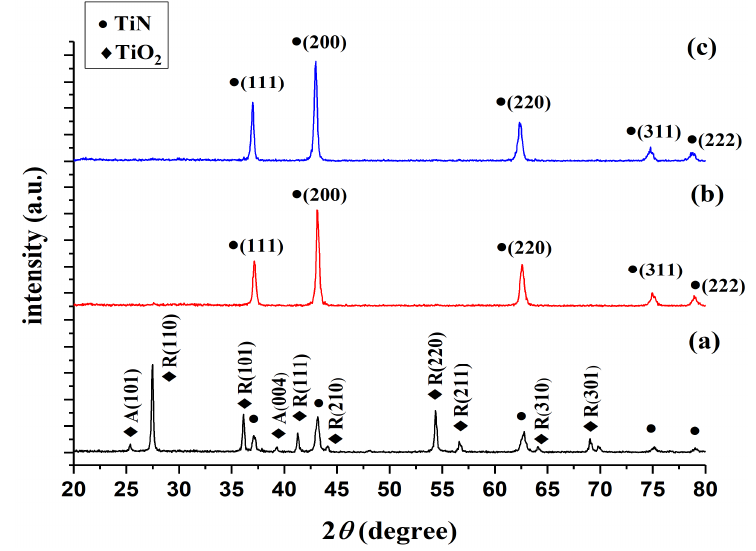
Figure 2. X-ray diffraction (XRD) graphs of TiN powders formed at different nitriding temperatures. Note: A is the anatase phase, whereas R is the rutile phase.